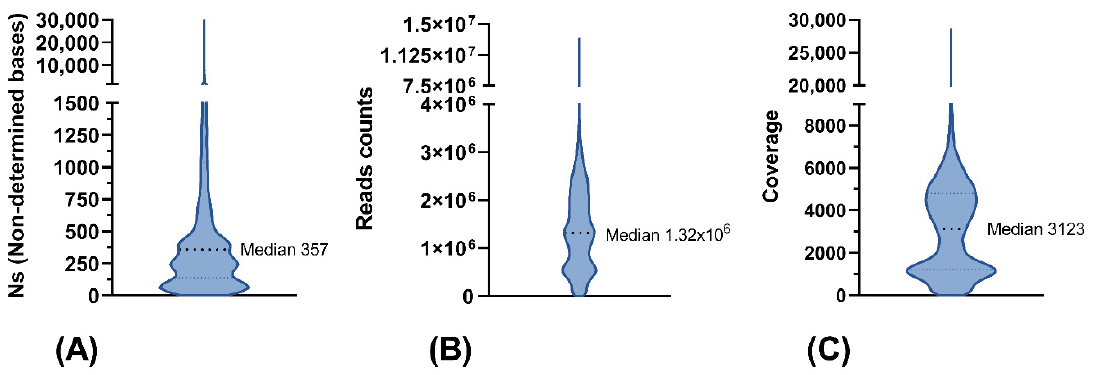
Figure 5. Summary of three analyzed NGS metrics. ( A ) Profile of undetermined bases with median value 357 ( B ) Profile of read counts with median value 1.32 × 10 6 ( C ) Coverage of known part of the genome with median value 3123.